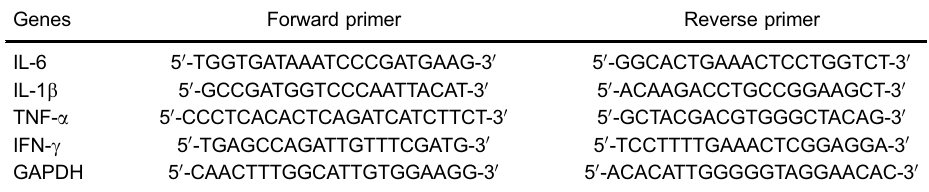
Table 1. Primer sequences for quantitative real-time